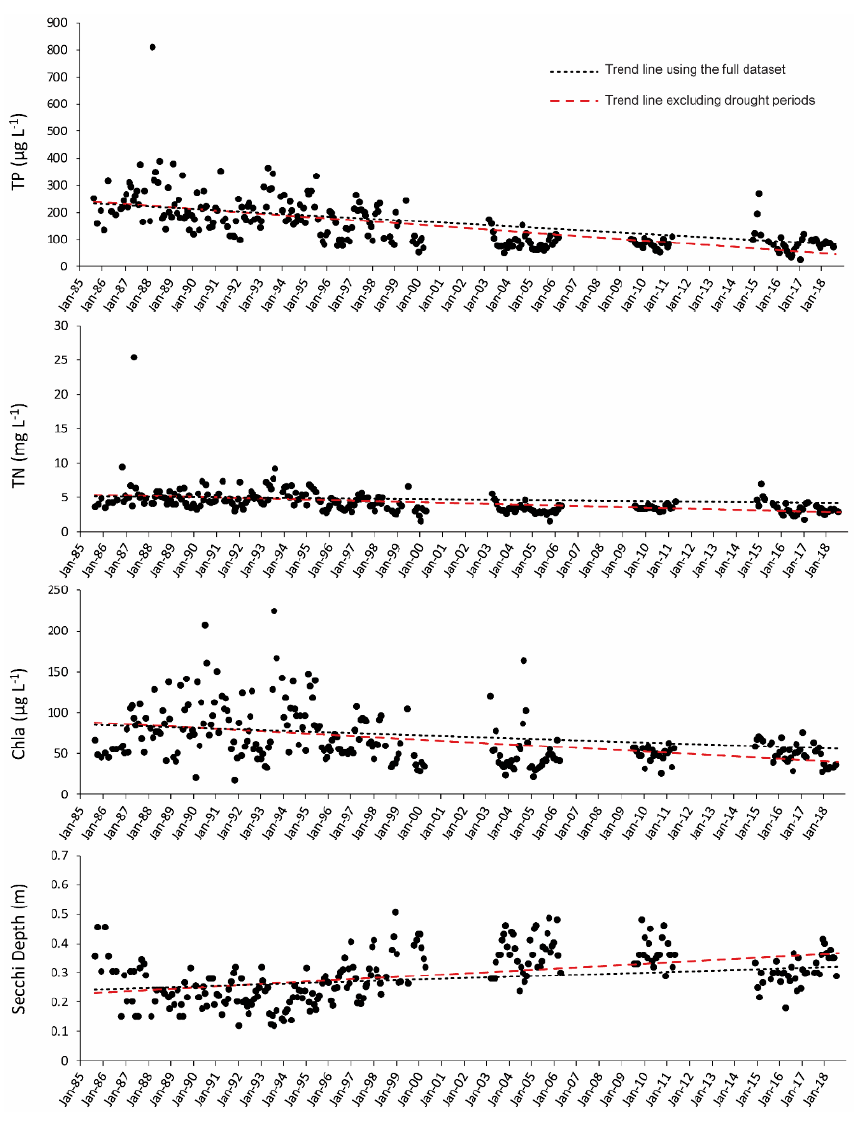
Figure 4. The long-term trends in water quality excluding those data during droughts. All the trends are significant ( p < 0.001). TP: total phosphorus, TN: total nitrogen, chl-a: chlorophyll-a. Large-scale improvements in water quality happened between 1985 and 2018 when looking only at data with comparable water depths (Figure 5). The mean TP was 207 µ g L − 1 during the first period but fell to 91 µ g L − 1 in the second period ( p < 0.001) and this change persisted in the third and fourth time periods. The same patterns were found for TN, Chl-a, and SD, except that SD declined somewhat in the most recent period of